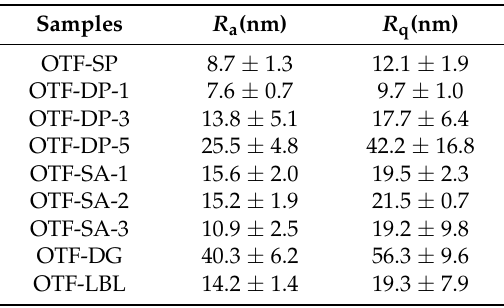
Table 1. Roughness of MOF optical thin